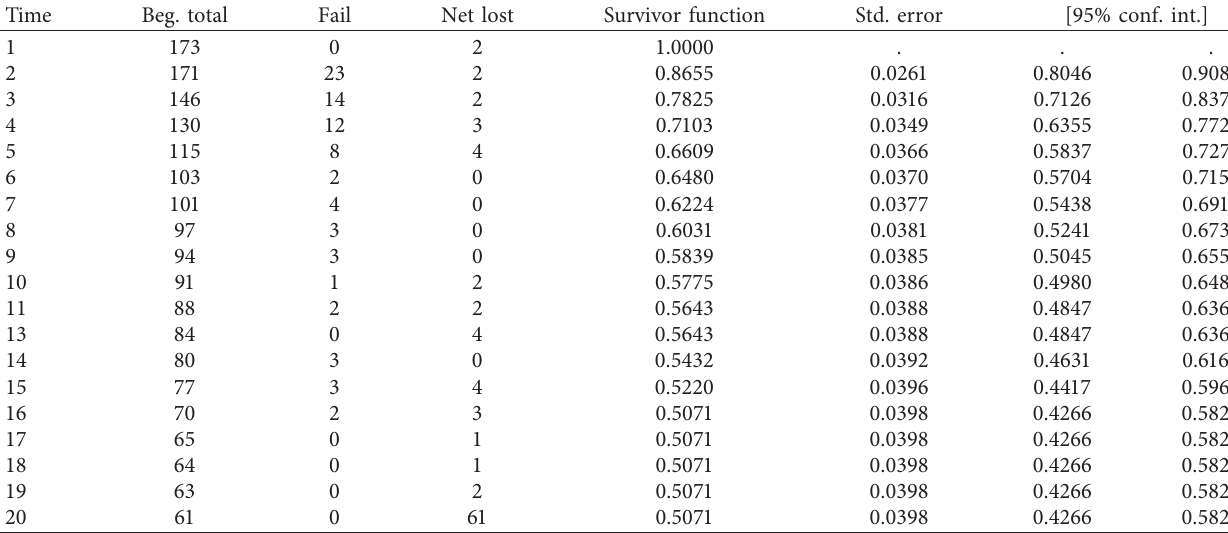
Table 3: Kaplan–Meier survival analysis of Chinese RSCA index (2001–2020).